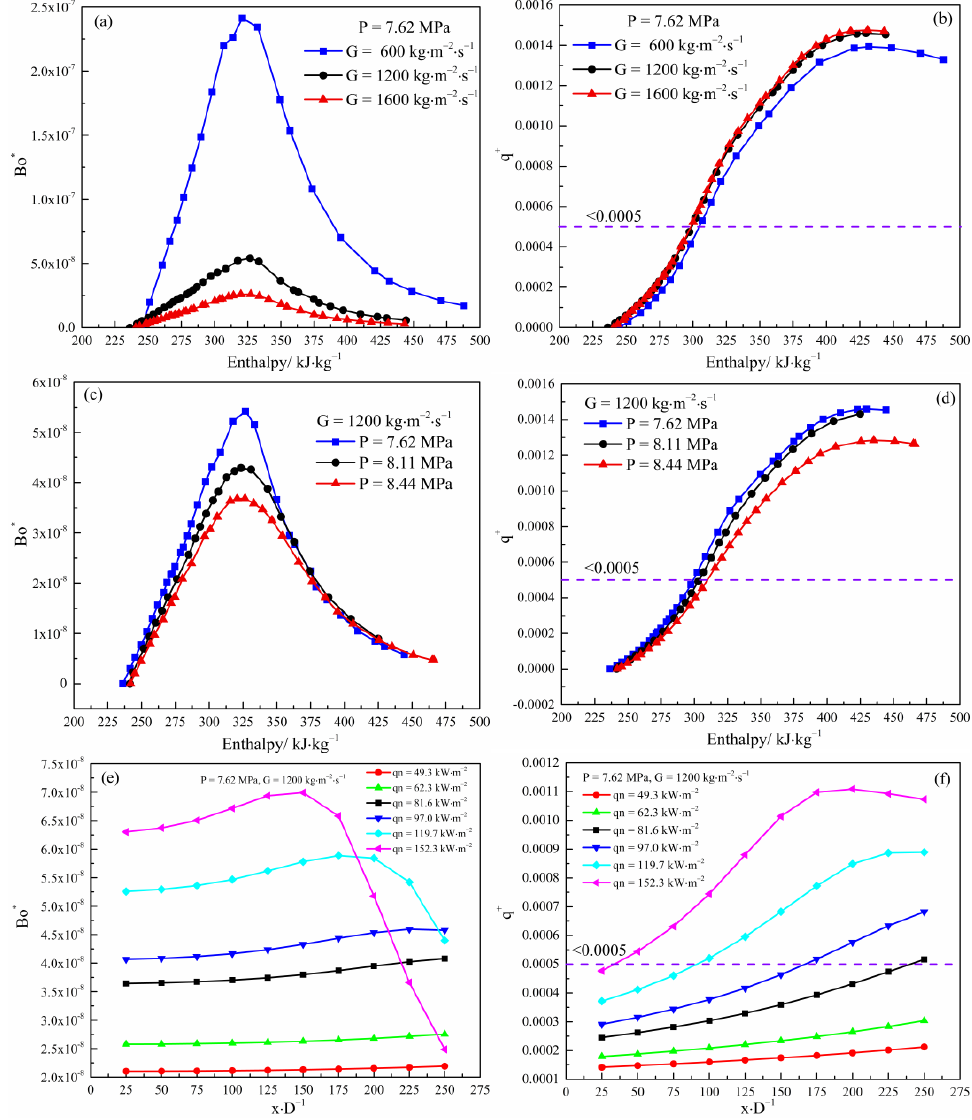
Figure 10. The variation of buoyancy and flow acceleration parameters under different mass flux, pressure, and heat flux values. ( a ) the effect of different pressure on buoyancy, ( b ) the effect of different pressure on flow acceleration, ( c ) the effect of different mass flux on buoyancy, ( d ) the effect of different mass flux on flow acceleration, ( e ) the effect of different heat flux on buoyancy, ( f ) the effect of different heat flux on flow acceleration.